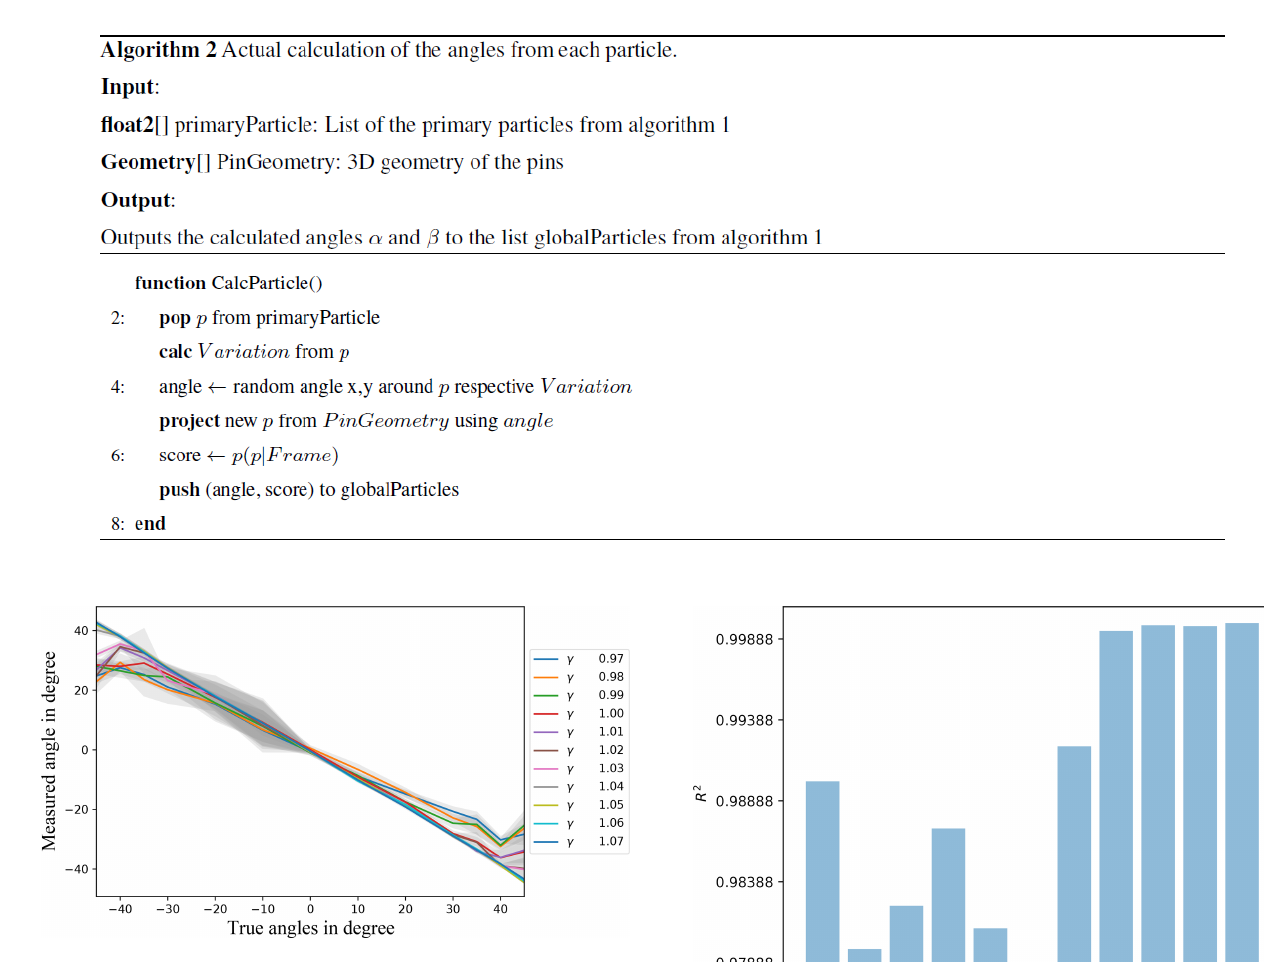
Figure 4. Radiation incident angles using data measured by the Timepix3 detector with the algorithm plotted over the true angles α . Each data point here was generated by calculating the mean value over five successive frames with the same true incident angle α and five evaluations of the same frame. The measurement was done us- ing an H-60 radiation quality (ISO, 2019). The different lines corre- spond to one γ that was used as the shadow threshold in the shadow detection algorithm. The standard deviation is indicated by the grey backdrop area.